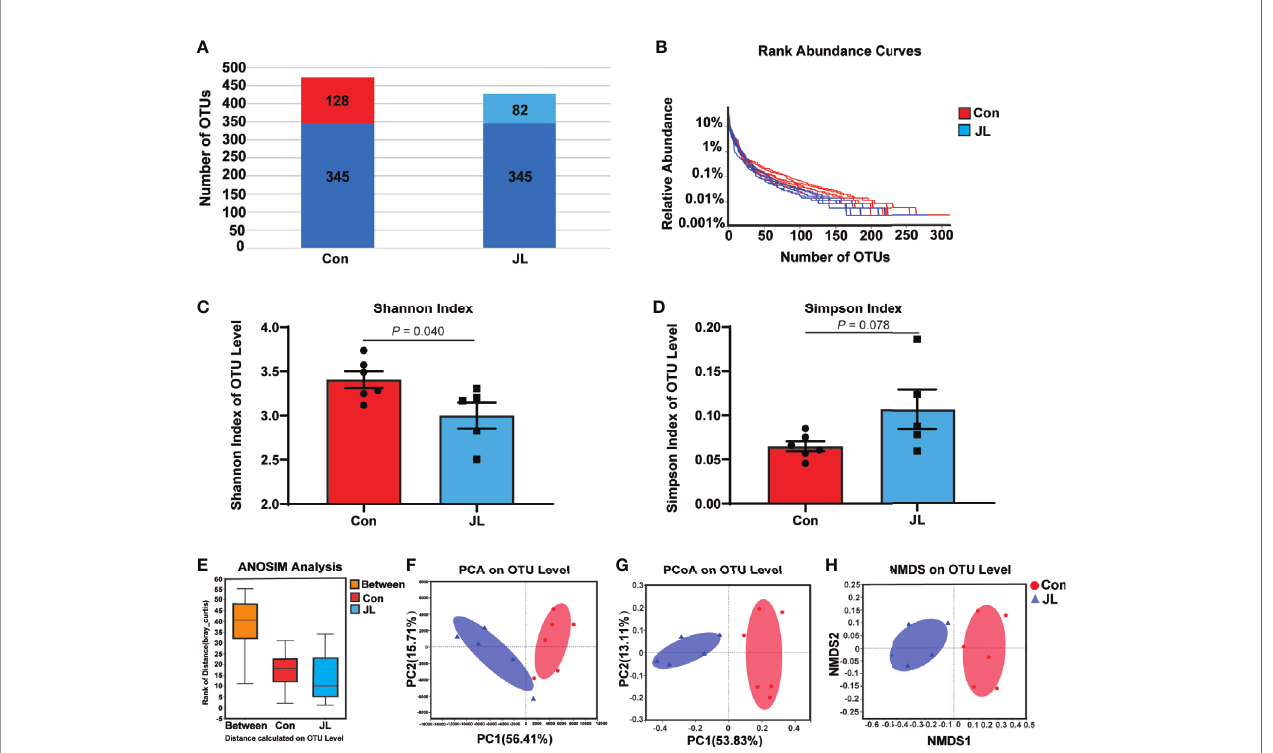
FIGURE 1 | Comparison of bacterial components, abundance, a -diversity (Shannon index and Simpson index), ANOSIM analysis, and b -diversity (PCA, PCoA, and NMDS) based on OTU level in colonic microbiota of normal rhythm mice (Con; n = 6) and jet-lagged mice (JL; n = 5). (A) The number of OTUs in Con and JL groups. The identical OTUs in two groups were marked in dark blue. (B) Rank-abundance curves indicate the abundance of colonic microbiota of two groups. (C) Shannon index, and (D) Simpson index of Con and JL groups. (E) ANOSIM analysis between two groups. (F) PCA, (G) PCoA, and (H) NMDS analysis of colonic microbiota. Values are presented as the means ± SEM. a -diversity was assessed by student ’ s t test and b -diversity was assessed by ANOSIM